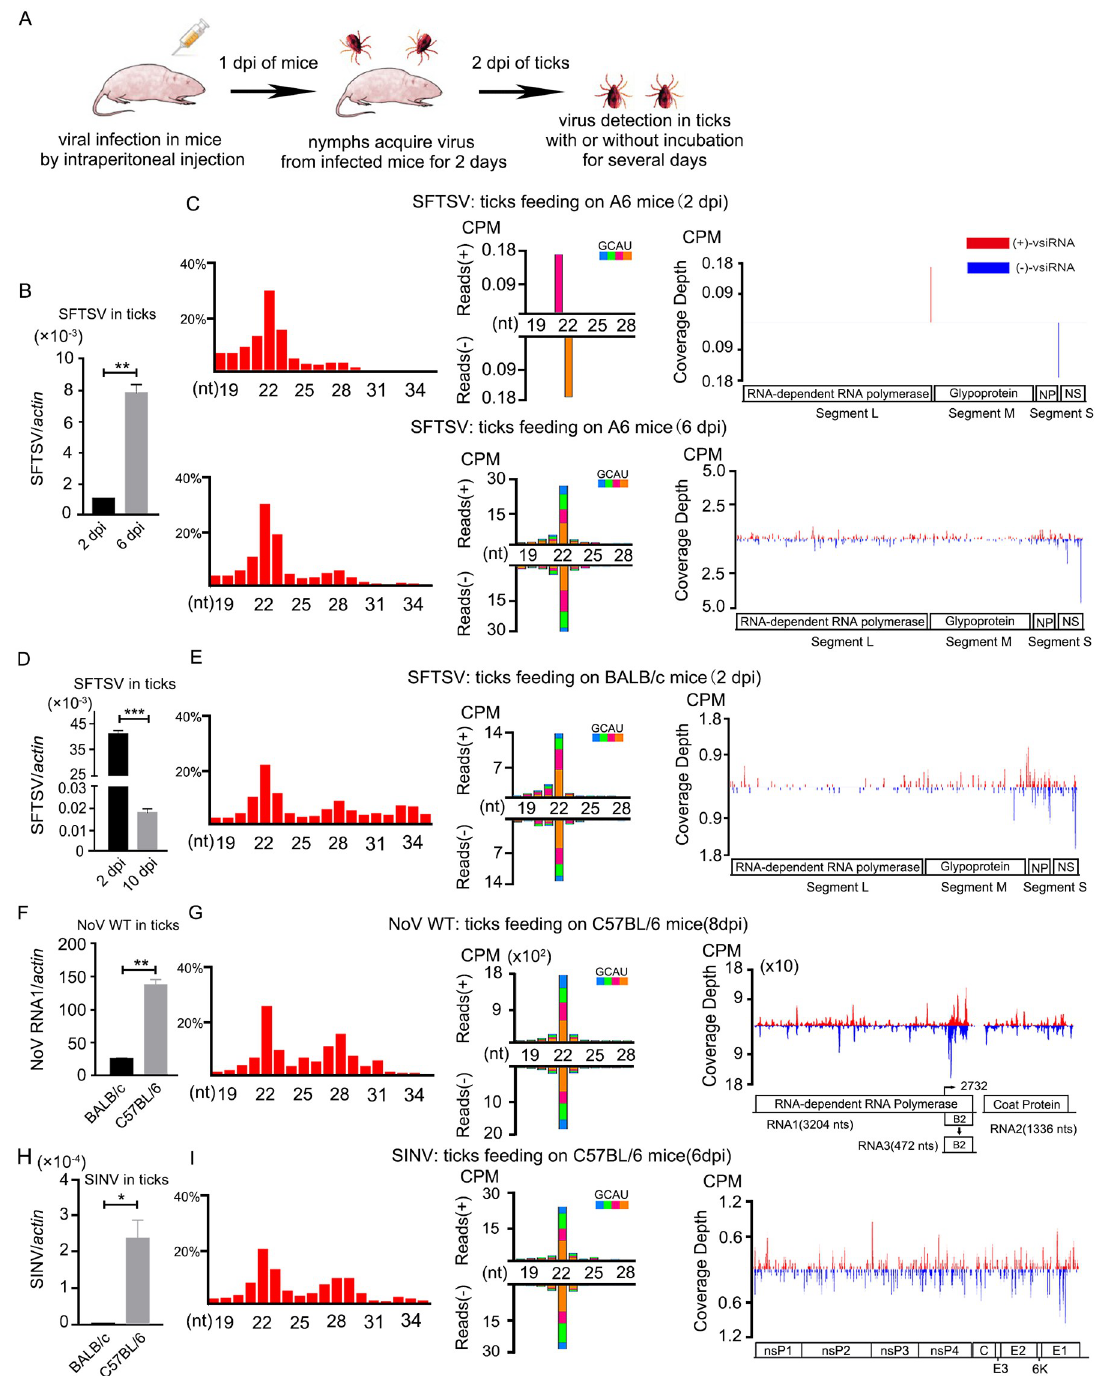
Fig 1. Profiles of vsiRNAs in infected H . longicornis ticks through blood feeding. (A) Schematic overview of viral acquisition by ticks through blood feeding. Briefly, nymphs were infected with the virus by blood feeding for two days on the virus-infected suckling mice. For infected ticks, the infection time was marked as 2dpi when ticks were removed from mice. If removed ticks were incubated for several days, the infection time was marked as (2+incubation days) dpi. (B) Viral RNA levels of SFTSV in ticks at 2dpi and 6dpi (incubation for 4 days) after sucking on infected A6 mice were determined by RT-qPCR. (C) Size distribution of total reads (left), virus- derived small RNAs (middle) and genomic coverage depth of 21- to 23-nt vsiRNAs (right) sequenced from ticks infected with SFTSV by blood feeding at 2dpi and 6dpi. For negative strand RNA virus, SFTSV, (+)-vsiRNA means antigenome vsiRNA. (D) Viral RNA levels of SFTSV in ticks at 2dpi and 10dpi (incubation for 8 days) after sucking on infected BALB/c mice were determined by RT-qPCR. (E) Size